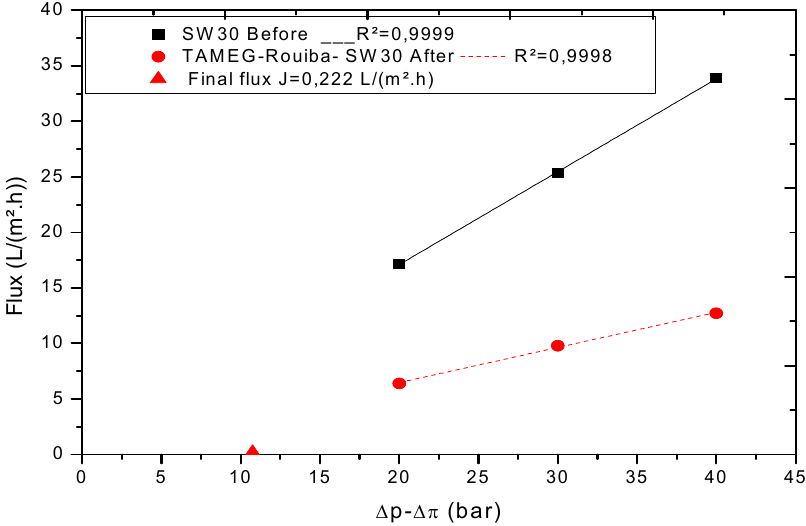
Figure 3. Evolvement of normalized flux profiles of a TAMEG ‐ Rouiba effluent treated by reverse osmosis with an SW30 membrane.